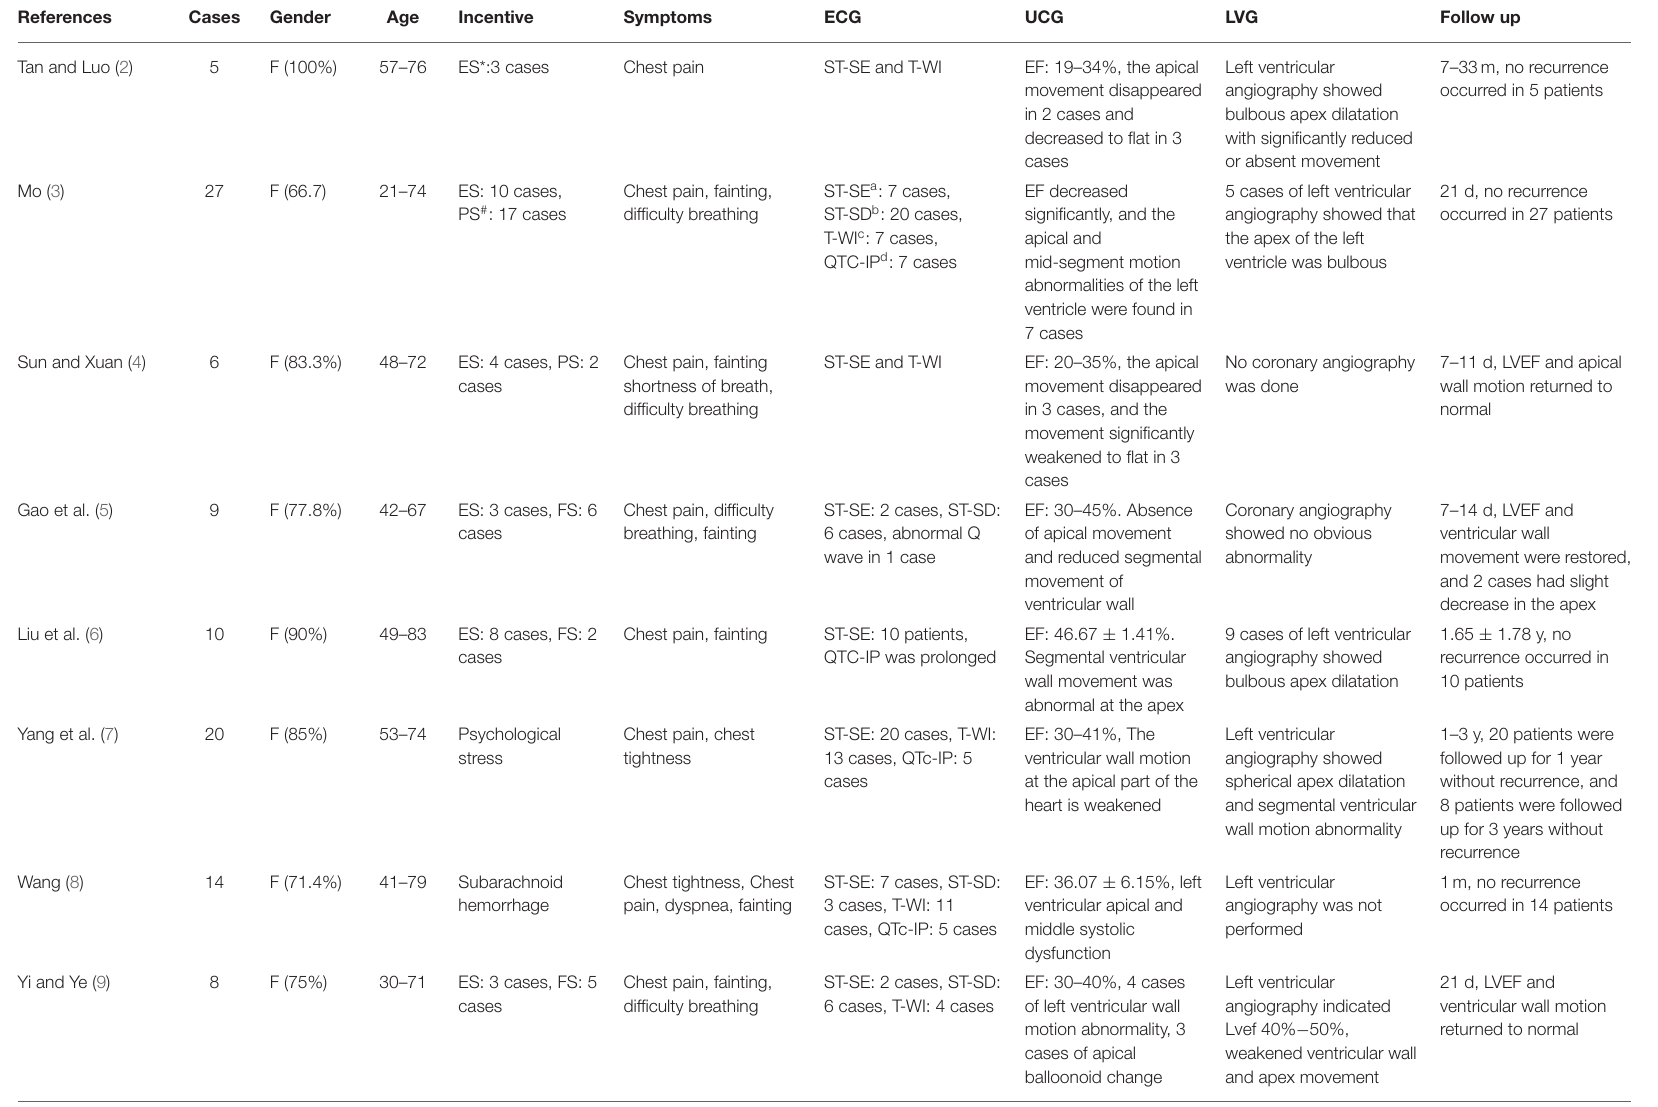
TABLE 1 | Onset characteristics of Takotsubo syndrome in some Chinese